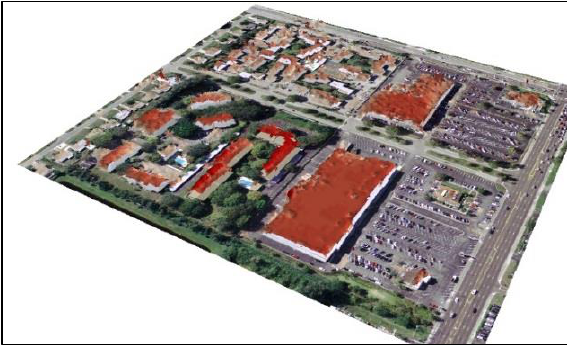
Figure 9. 3D View of the Detected Buildings